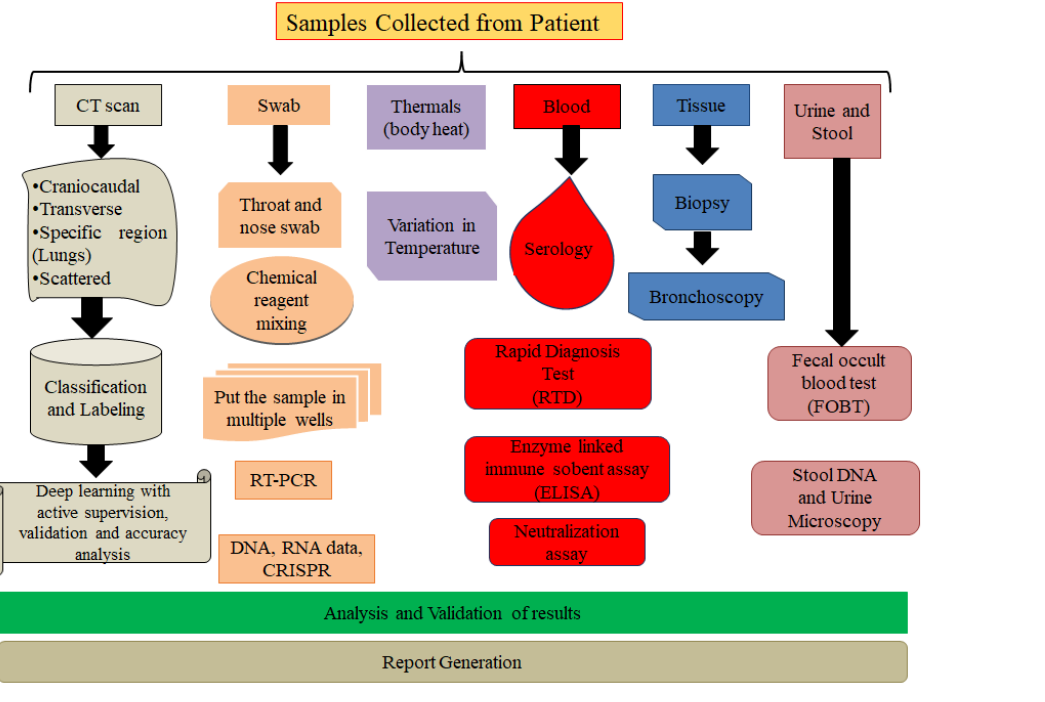
Figure 7. Intelligent Sensing in Pandemic Monitoring.